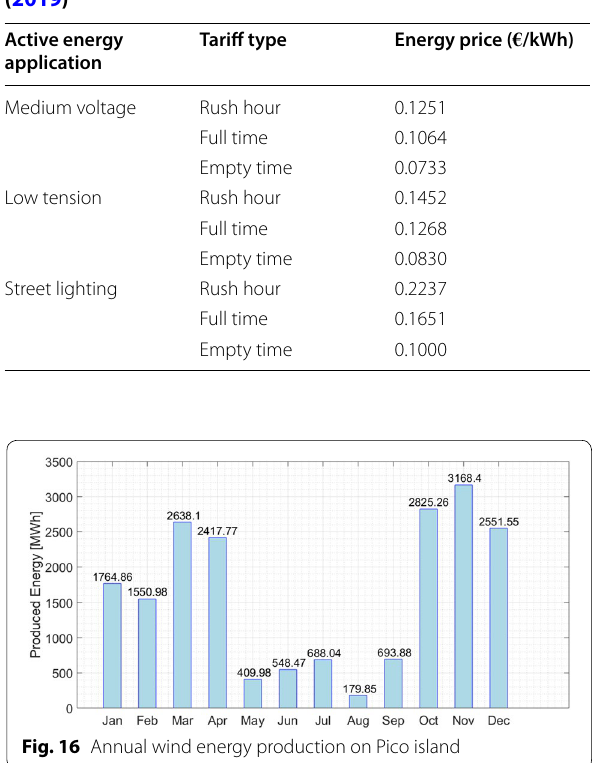
Table 19 Tariffs in the autonomous region